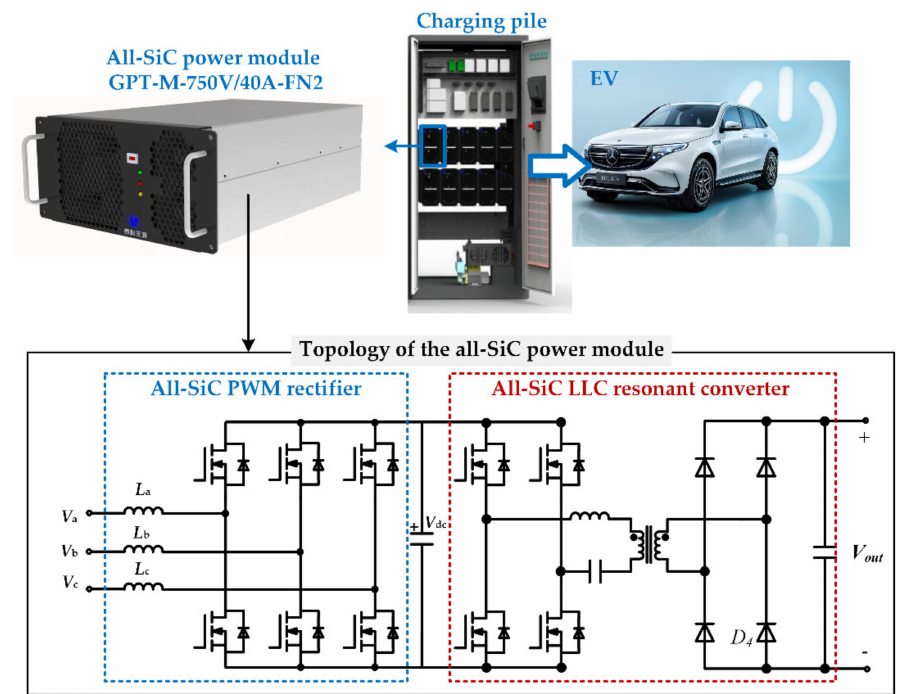
Figure 1. The outlook of the electric vehicle (EV) charging pile and the topological diagram of its all-SiC (silicon carbide) power module with the Pulse Width Modulation (PWM)